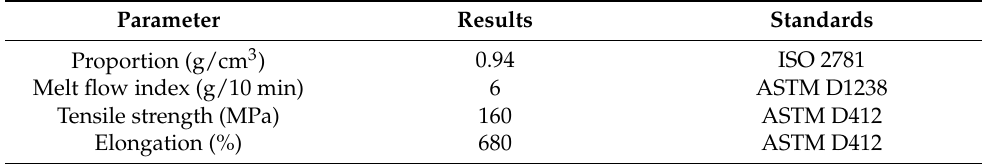
Table 4. Basic properties of